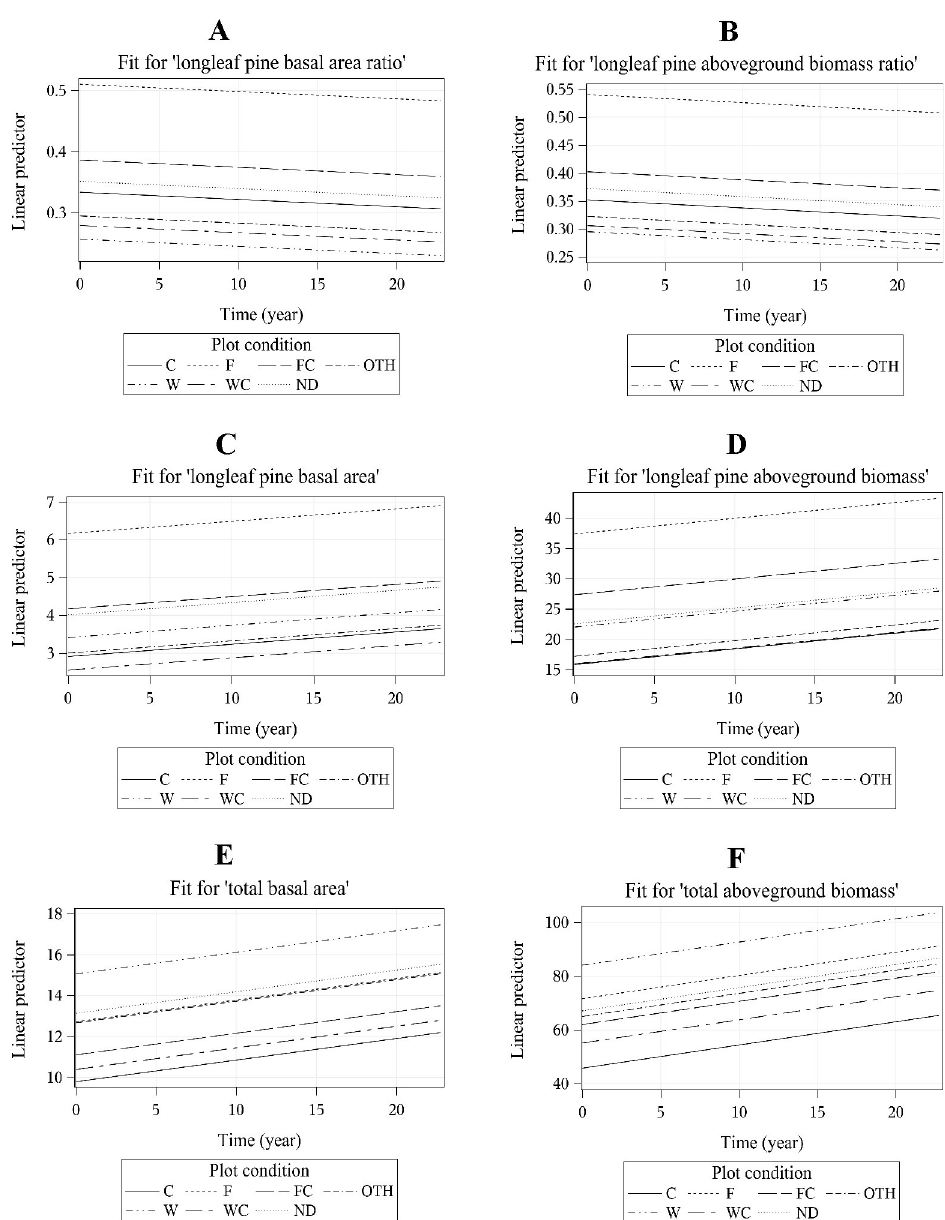
Fig 8. Fitted effect plots of linear mixed models (model 4) exhibit the relationship between outcome variables and plot remeasurement period (time) by plot condition. Basal area measured in m 2 ha -1 and aboveground biomass in Mg ha -1 . Plot condition codes are described in Table